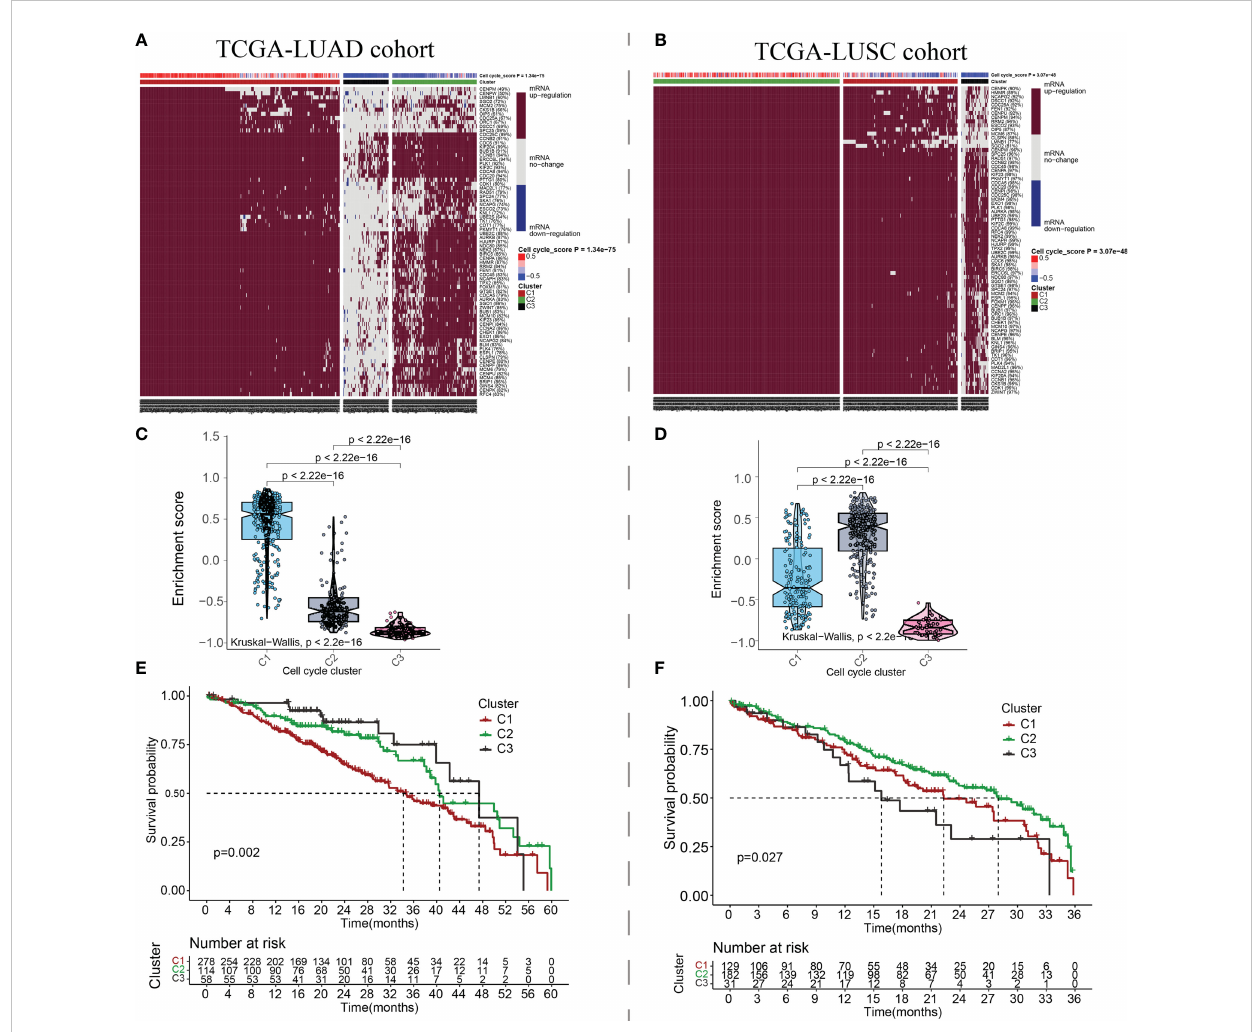
FIGURE 4 Cluster analysis based on the cell cycle-related genes. The patients with NSCLC in the TCGA-LUAD and TCGA-LUSC cohorts were successfully grouped into 3 clusters for LUAD (A) and LUSC (B) . Pathway enrichment scores followed the trend C1 > C2 > C3 in LUAD (C) and C2 > C1 > C3 in LUSC (D) . Three different clusters showed different survival curves. Cluster 1 has the worse survival rate in LUAD (E) . However, Cluster 1 has the worse survival rate in LUSC (F) . x indicates survival time and y indicates survival